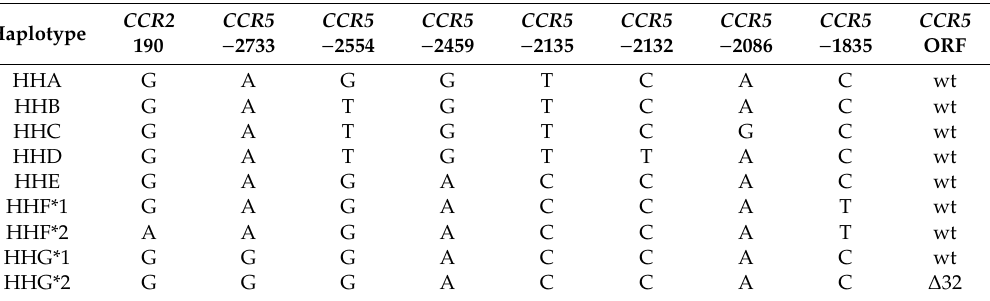
Table 1. CCR5 haplotype nomenclature †